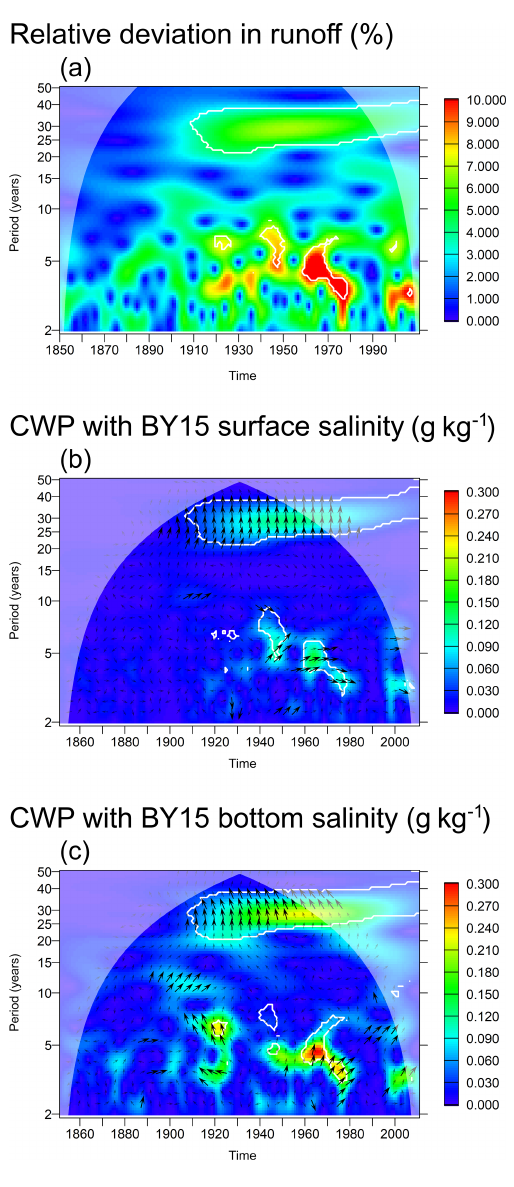
Figure 9. (a) Wavelet amplitude of the relative deviation in runoff of all model rivers inside the ArkonaSea transect; see Fig. 1. (b) Common wavelet power between modelled surface salinity at sta- tion BY15 (Eastern Gotland Basin,g kg − 1 ) and normalized runoff; note that the scale is doubled from Fig. 8. (c) The same for bottom salinity. White contours indicate that the WA or CWP is signifi- cant at the 95% confidence level with respect to a random shuffling of the annual means of the runoff. Arrows indicate relative phase: → : high runoff and salinity in phase; ↑ : low runoff leading salinity by 90 ◦ . Thick arrows indicate phase stability (wavelet coherence >